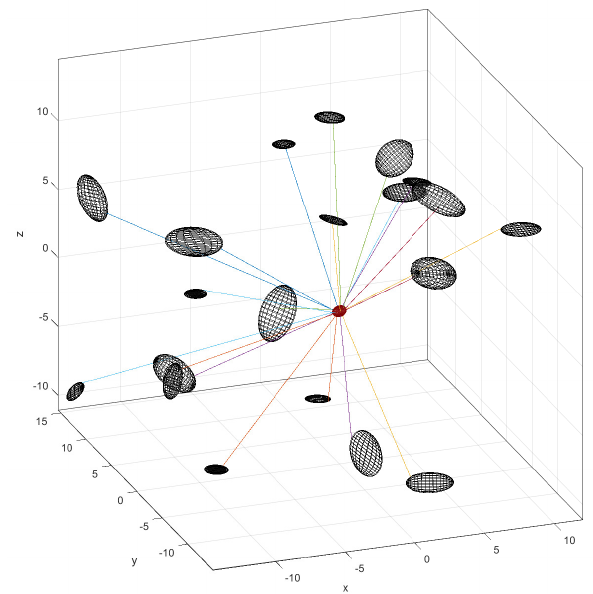
Figure 2. Examples of random generated samples for